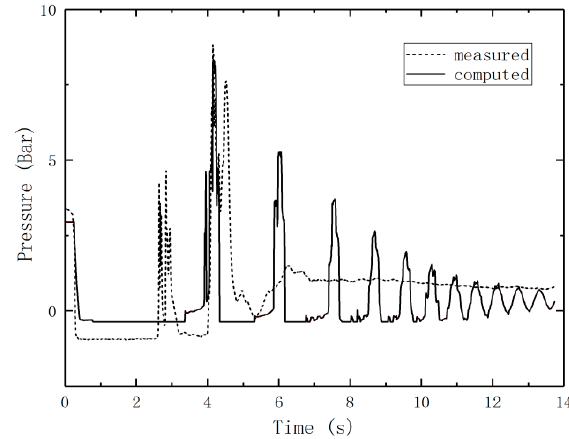
Figure 6. Comparison of measured and simulated pressures at the Number 4 measurement point after optimization.